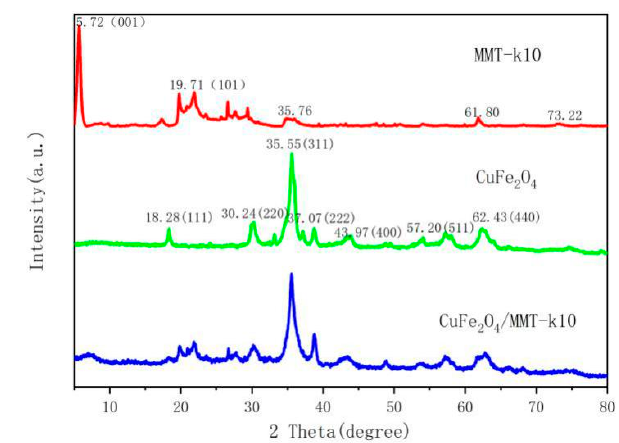
Figure 1. X-ray di ff raction (XRD) patterns of montmorillonite k10 (MMT-k10), CuFe 2 O 4 and Figure 1. X-ray diffraction (XRD) patterns of montmorillonite k10 (MMT-k10), CuFe 2 O 4 and CuFe 2 O 4 / CuFe 2 O 4 /MMT-k10.